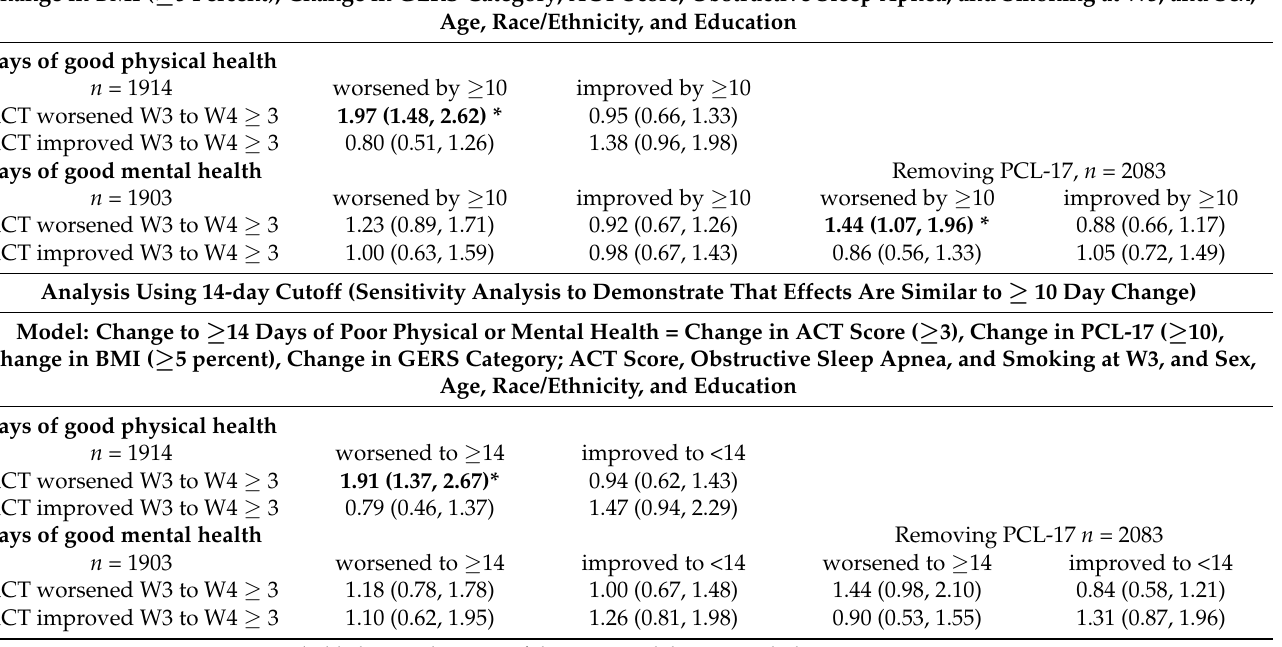
Table 5. Multivariable multinomial logistic regression, change in quality of life of 10 days poor health versus change in ACT score, W3 to